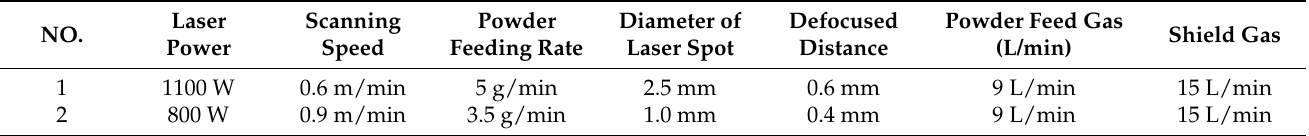
Table 6. Selected optimized repairing parameters in single pass under laser spot diameters of 1.0 and